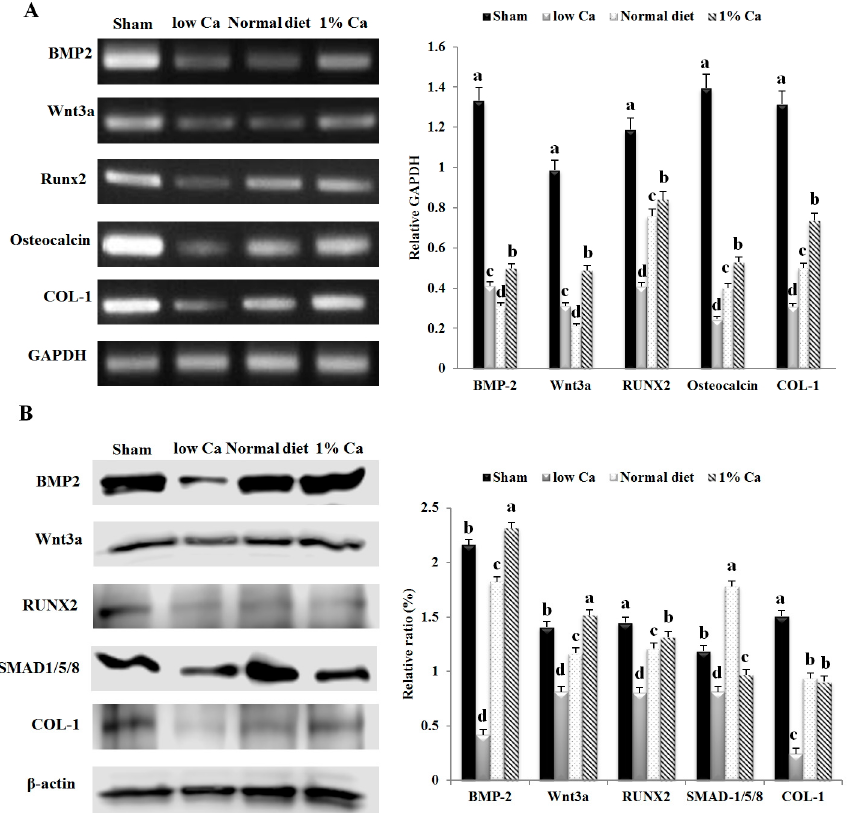
Figure 4. The expression of mRNA and protein levels of molecules involved in bone metabolism in sham, low Ca, normal diet, and 1% Ca groups. ( A ) The mRNA expression of bone morphogenetic protein-2 (BMP-2), Wnt3a, runt-related transcription factor 2 (RUNX2), osteocalcin and collagenase-1 (COL-1) in sham, low Ca, normal diet and 1% Ca groups; ( B ) The protein expression of BMP-2, Wnt3a, RUNX2, small mothers against decapentaplegic (SMAD)1/5/8, and COL-1 in sham, low Ca, normal diet and 1% Ca groups. Results are expressed as the means ± standard deviation (SD). Values not sharing a common superscript ( a , b , c , and d ) differed significantly (Duncan’s multiple range test).